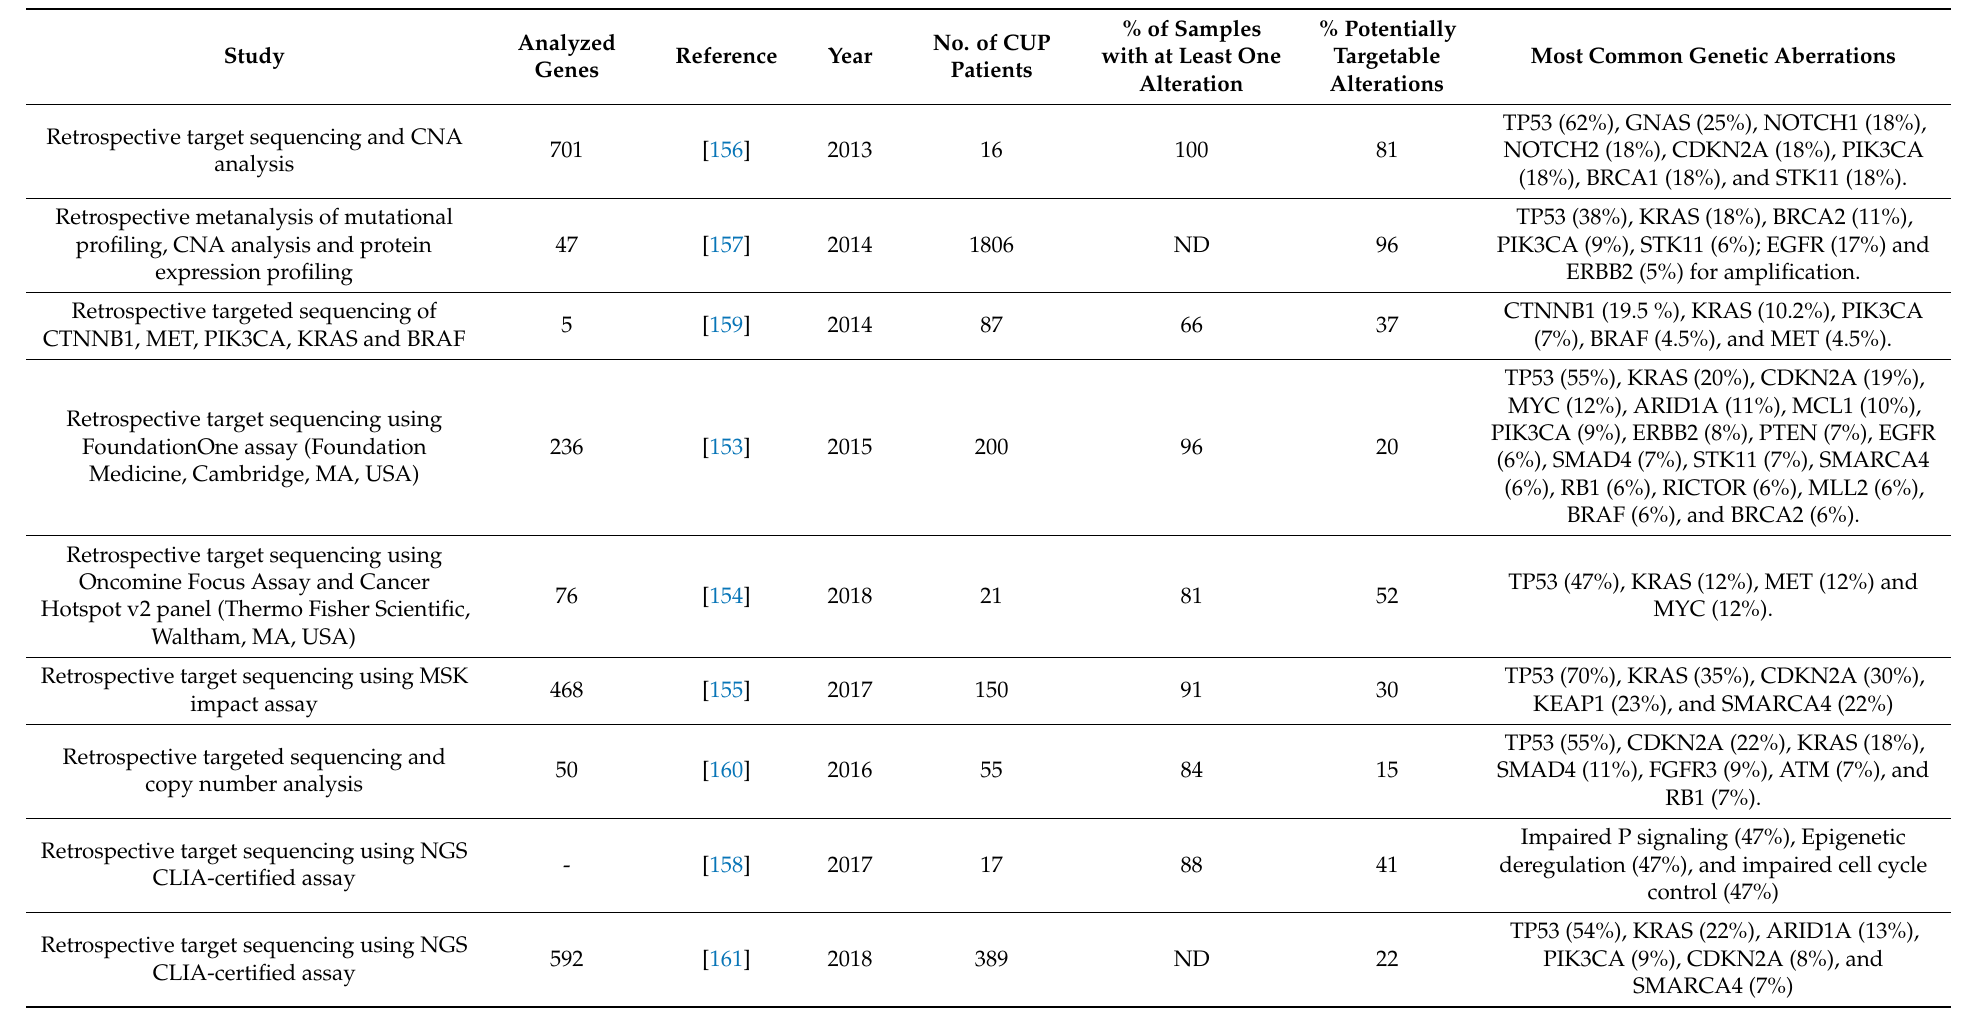
Table 3. Studies analyzing the mutational landscape of CUP